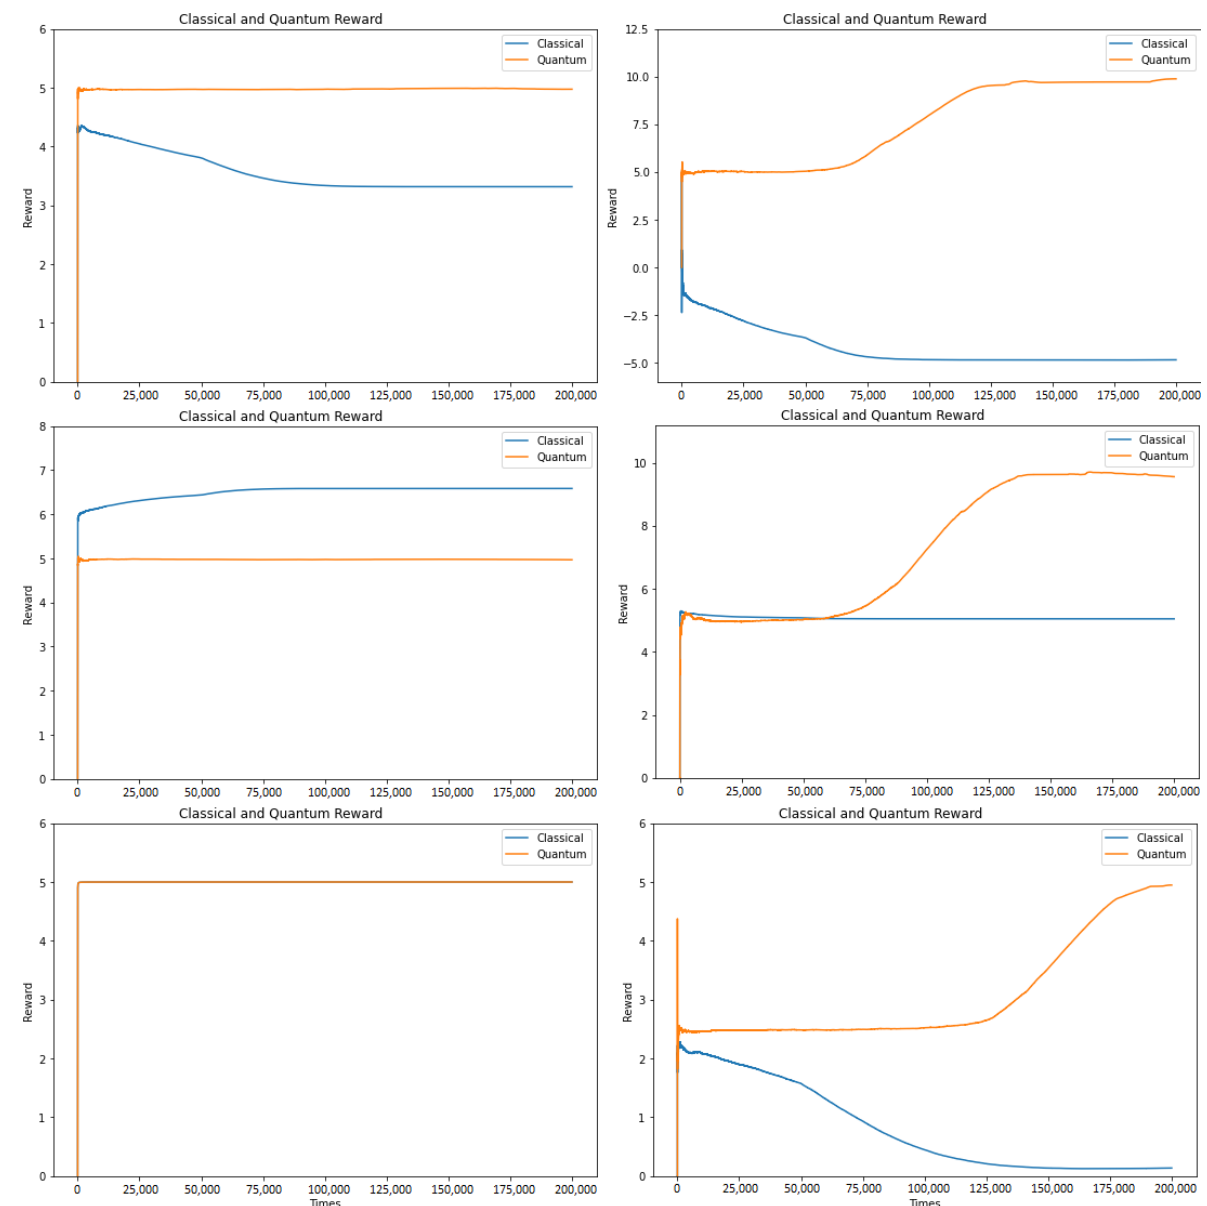
Figure 4. Average reward (from a window of the last 50,000 values) for agents learning how to play. Games from left to right. First row: Prisoner’s Dilemma v1 and Prisoner’s Dilemma v2. Second row: Deadlock game v1 and Deadlock game v2. Third row: disco-ordination game and selfish